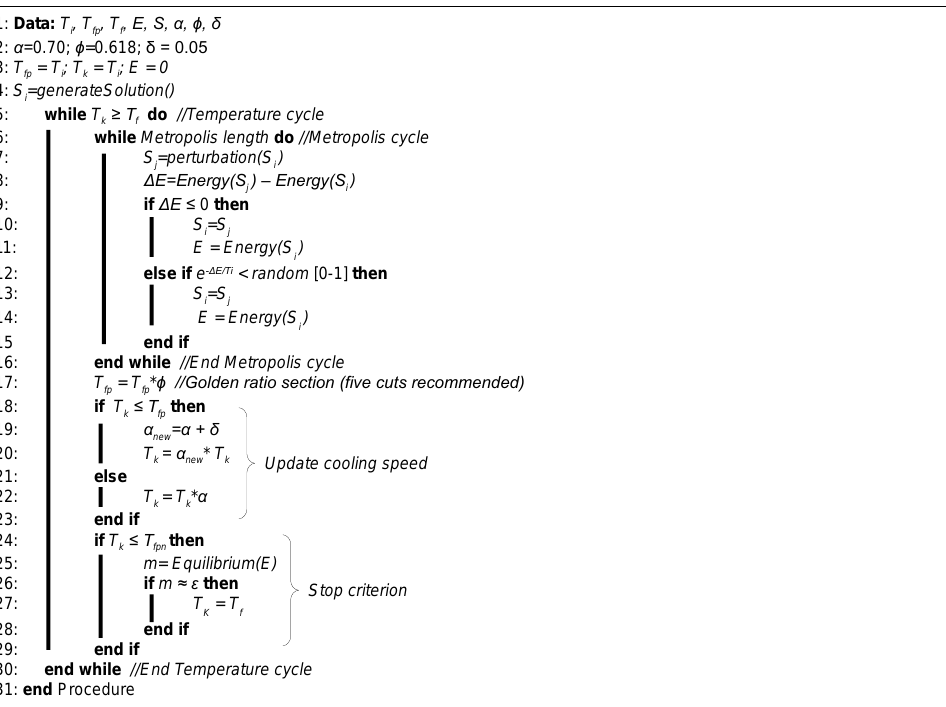
Algorithm 2.1 Equilibrium Function 1: Equilibrium(E)